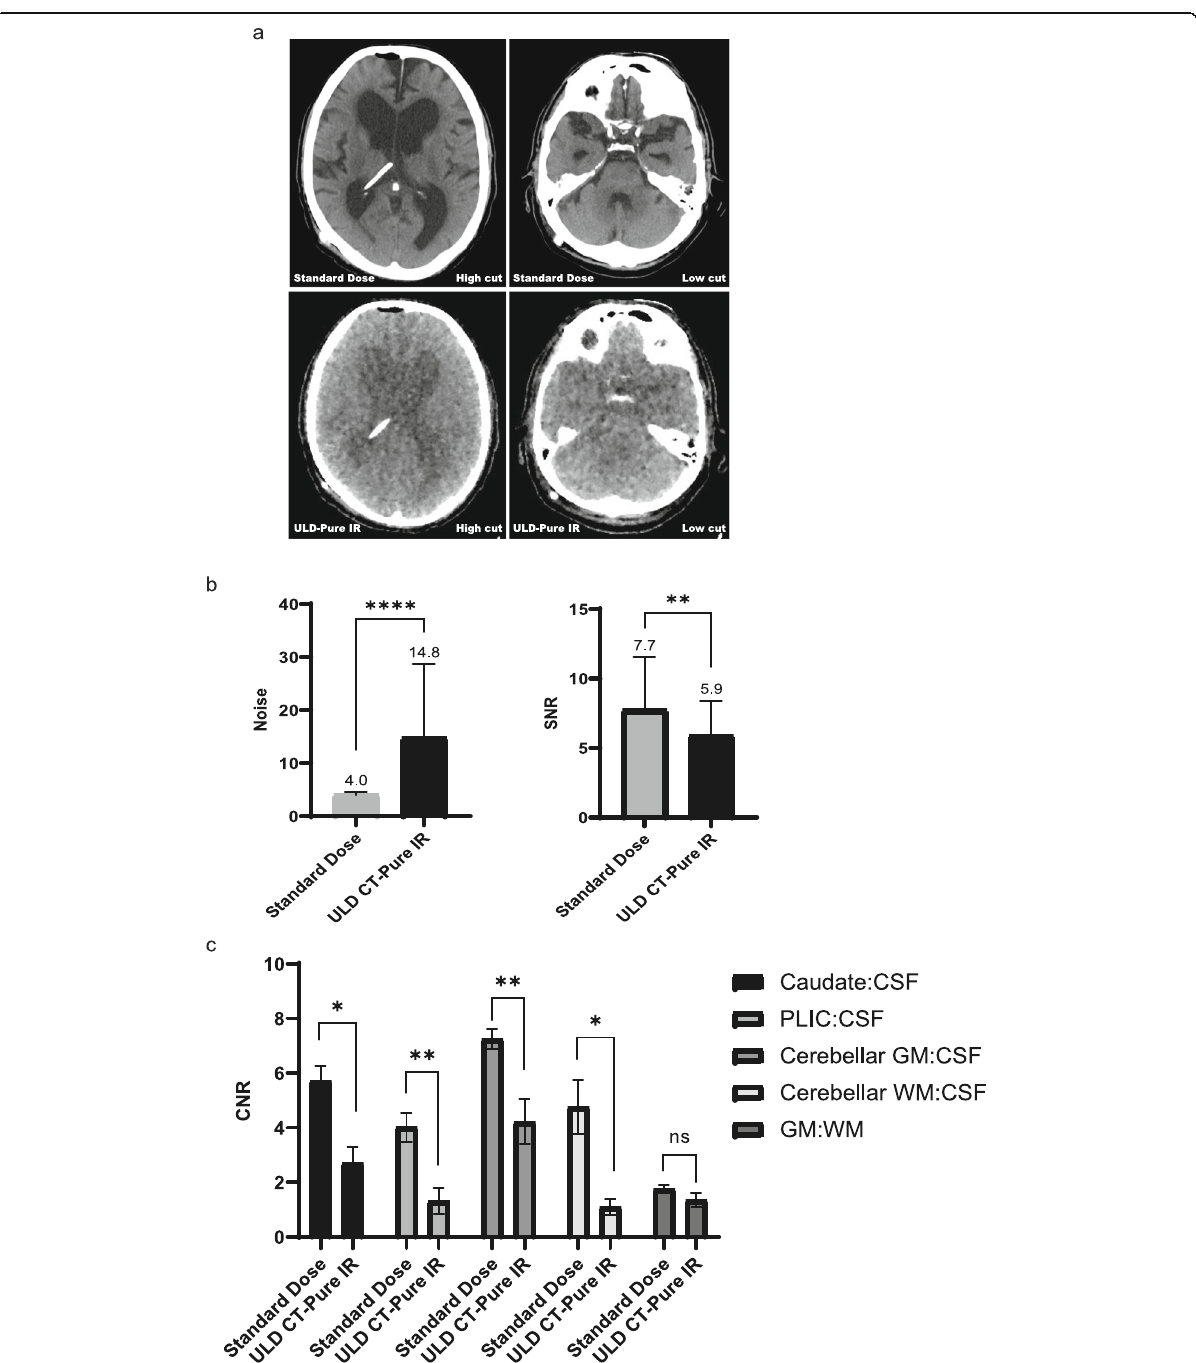
Fig. 7 Increase in image noise for brain ULD CT with pure IR. a Two-level axial (3-mm slice thickness) computed tomography images acquired using standard dose and ULD in the same patient. Although discrimination of the ventricles is achieved on ULD CT with pure IR, subjective noise is high and image contrast is poor. b Image noise and SNRs in the standard dose and ULD CT with pure IR brain study from the same patients were compared. Difference in means for image noise and signal-to-noise ratio was assessed using a Wilcoxon matched-pairs signed rank test and paired samples t -test, respectively. Data represent the mean and standard deviation. A p -value < 0.05 was considered statistically significant. **** p < 0.001, ** p = 0.004. c Comparison of contrast-to-noise ratios between the two techniques was performed using a paired samples t -test. Caudate: CSF *p = 0.021; PLIC: CSF **p = 0.004; cerebellar GM: CSF ** p = 0.010. Cerebellar WM: CSF * p = 0.039. GM (caudate): WM (PLIC) p = 0.236. CT Computed tomography, CSF Cerebrospinal fluid, IR Iterative reconstruction, PLIC Posterior limb of internal capsule, GM Grey matter, WM White matter, ULD Ultralow